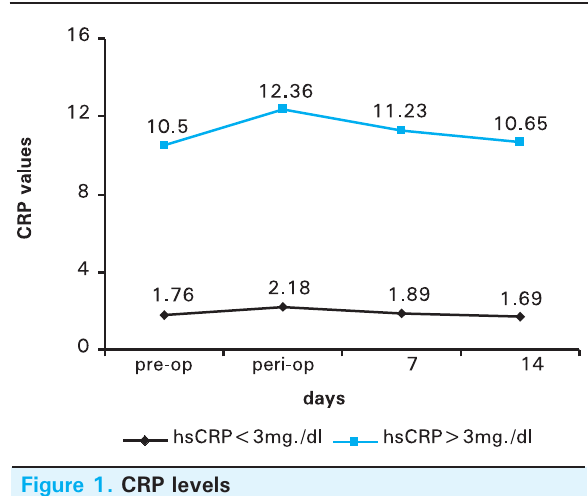
Figure 1. CRP levels Perioperative outcome is strongly associated with cardio respiratory fi tness which can be determined by cardiovascular exercise testing and myocardial ischaemia arising out of it which can predict complications in higher risk surgical patients. 5 Various studies substantiate the transient increased risk of myocardial infarction after infection. 16 Again, chronic infl ammatory conditions and autoimmune diseases like systemic lupus risk of cardiovascular complications. 17 There is steady association of hsCRP and cardiovascular